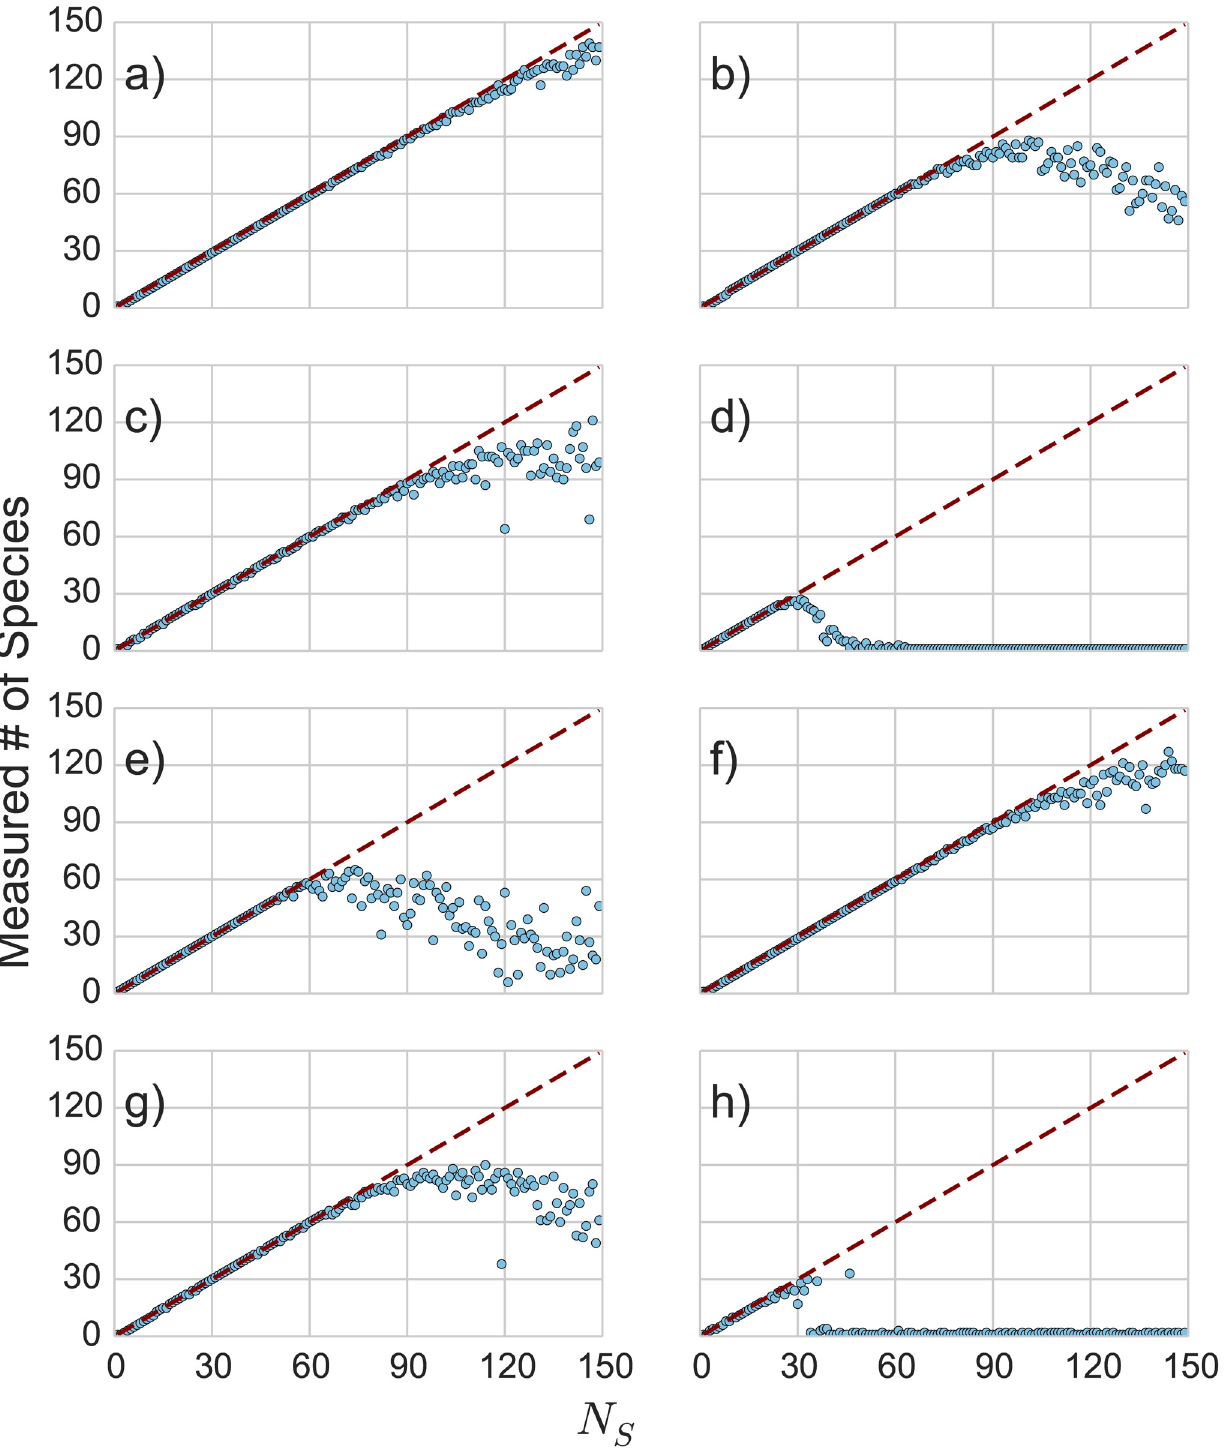
Fig 2. Behavior of the heredity metric on the species detection test case. For these plots, perfect detection corresponds to the line y = x . These cases use α = 0.1, N P = 1000, N f = 1000, and 10 extra duplicate sequences for regularization. a) f 1 = 0.5, m = 0.05, b) f 1 = 0.5, m = 0.2, c) f 1 = 0.05, m = 0.05, d) f 1 = 0.05, m = 0.2, e) f 1 = 0.05, m = 0.05, 0.2, f) f 1 = 0.05, 0.5, m = 0.05, g) f 1 = 0.05, 0.5, m = 0.05, 0.2, h) f 1 = 0.05, m = 0.05, heterogeneous